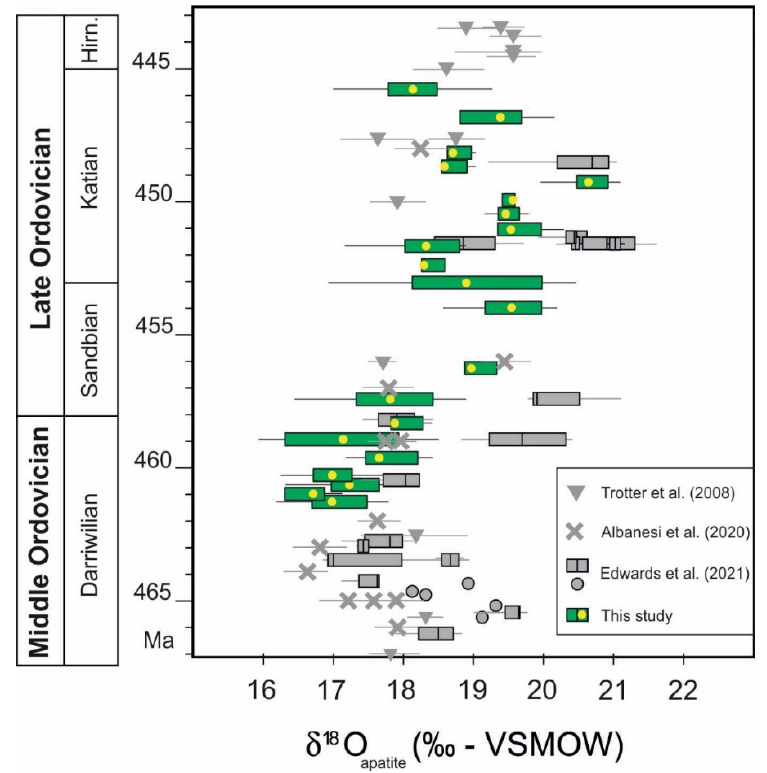
Figure 4. δ 18 O apatite values from this study and SIMS-based data from the literature Trotter et al. [5], Albanesi et al. [20], Edwards et al. [22] plotted relative to the Ordovician time scale Cooper et al. [56]. The location of studied samples on the time scale is approximately determined on the conodont zone